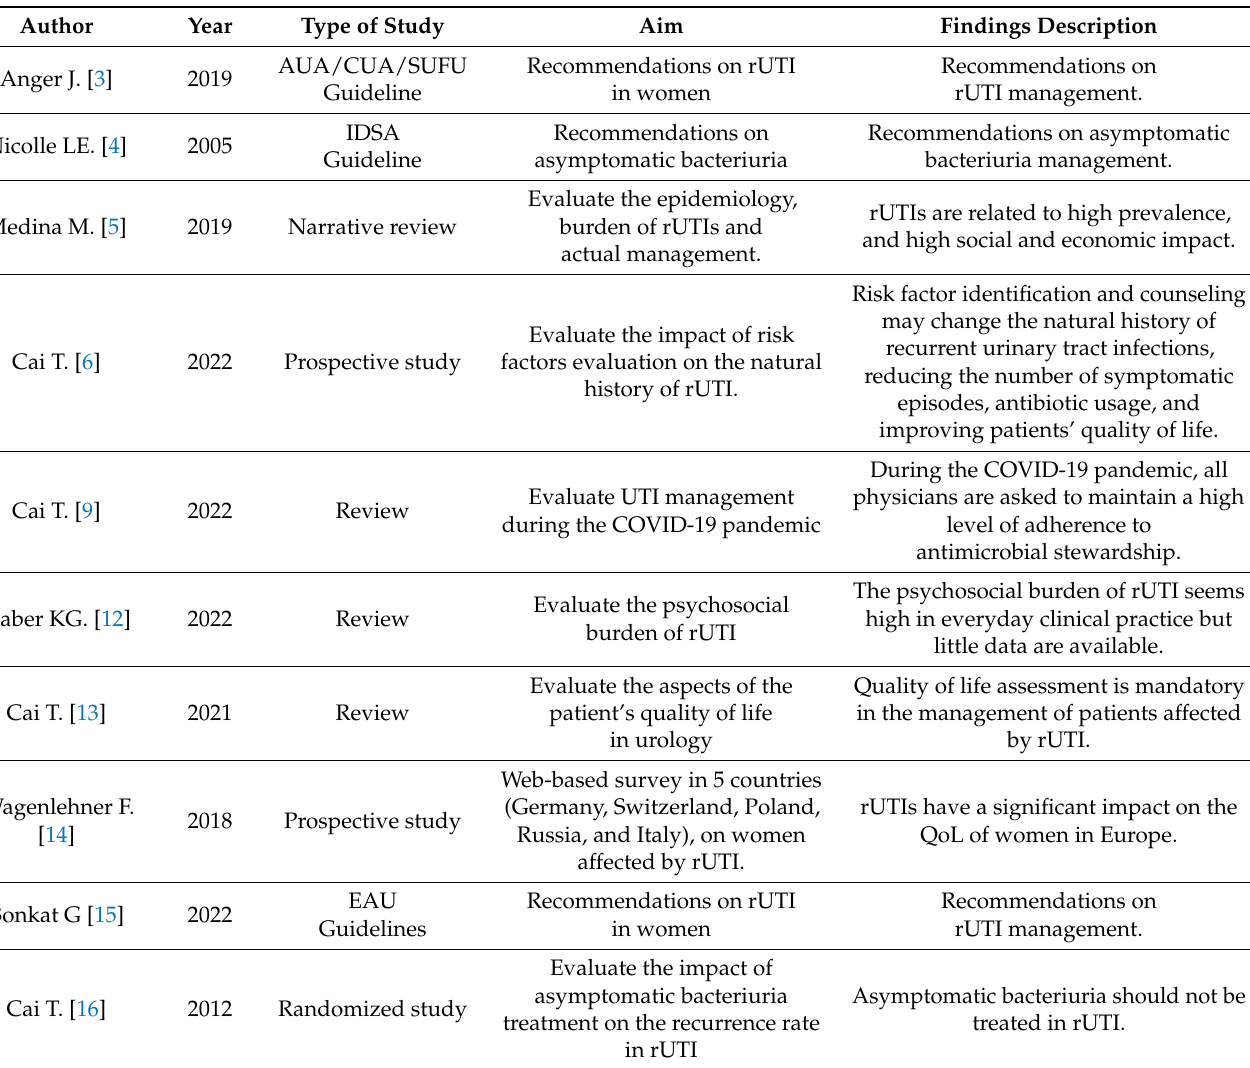
Table 1. The table shows the summary of all included studies in this narrative review. AUA: American Urological Association; CUA: Canadian Urological Association; SUFU: Society of Urodynamics, Female Pelvic Medicine and Urogenital Reconstruction; rUTI: recurrent Urinary Tract Infections; Infectious Diseases Society of America; QoL: Quality of life; LUTIRE nomogram: Lower Urinary Tract Infection Recurrent risk